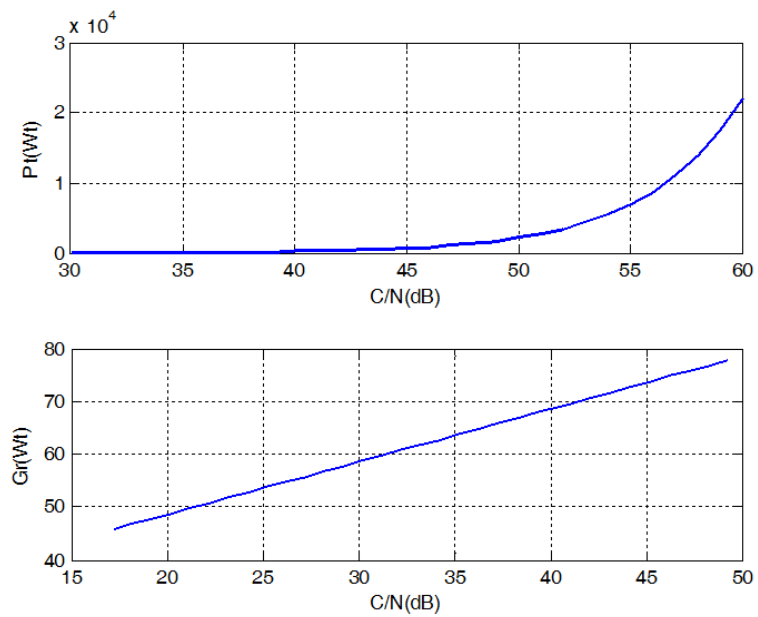
Figure 5. The transmitted power and antenna gain under different carrier noise